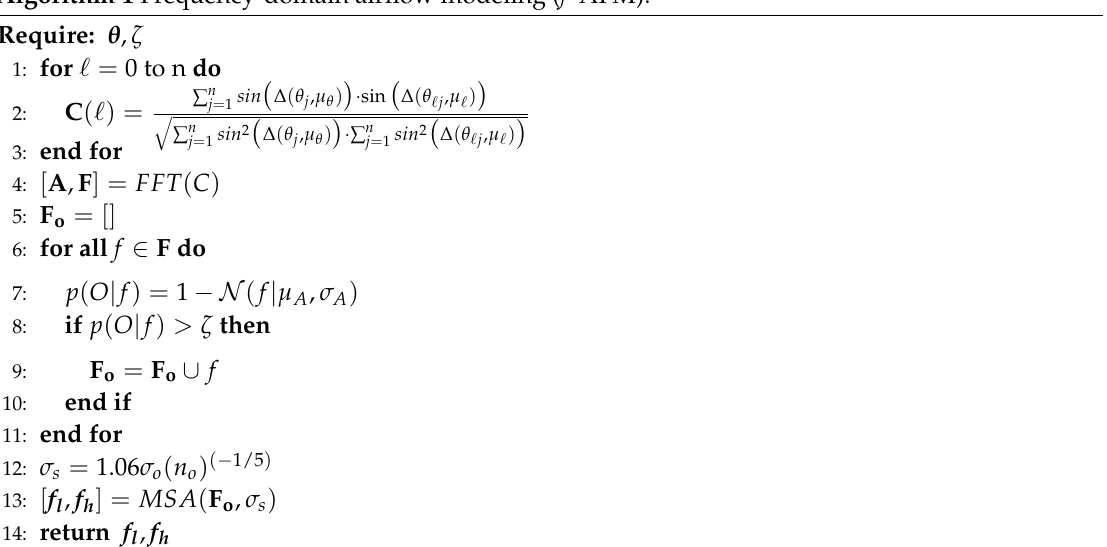
Algorithm 1 Frequency-domain airflow modeling ( f